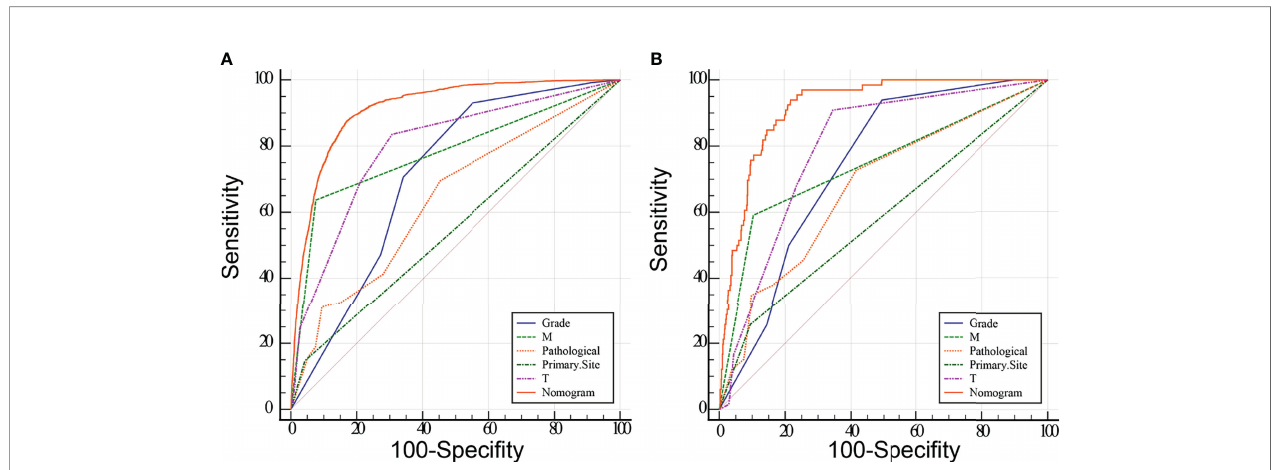
FIGURE 2 | Receiver operating characteristic (ROC) analyses of the nomogram and each independent predictor based on the training (A) and validation (B) group. The results show that the nomogram has better predictive performance than any single